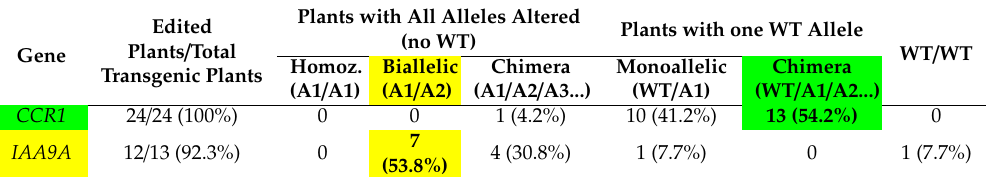
Table 1. Numbers of edited plants and type of mutations according to target genes.